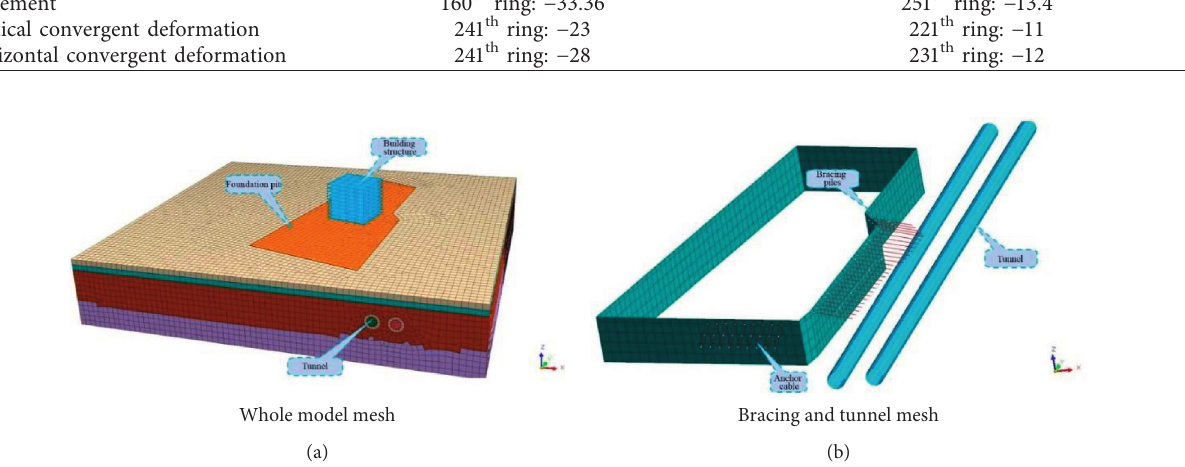
Figure 4: Numerical model established in MIDAS-GTS. (a) Whole model mesh. (b) Bracing and tunnel mesh.